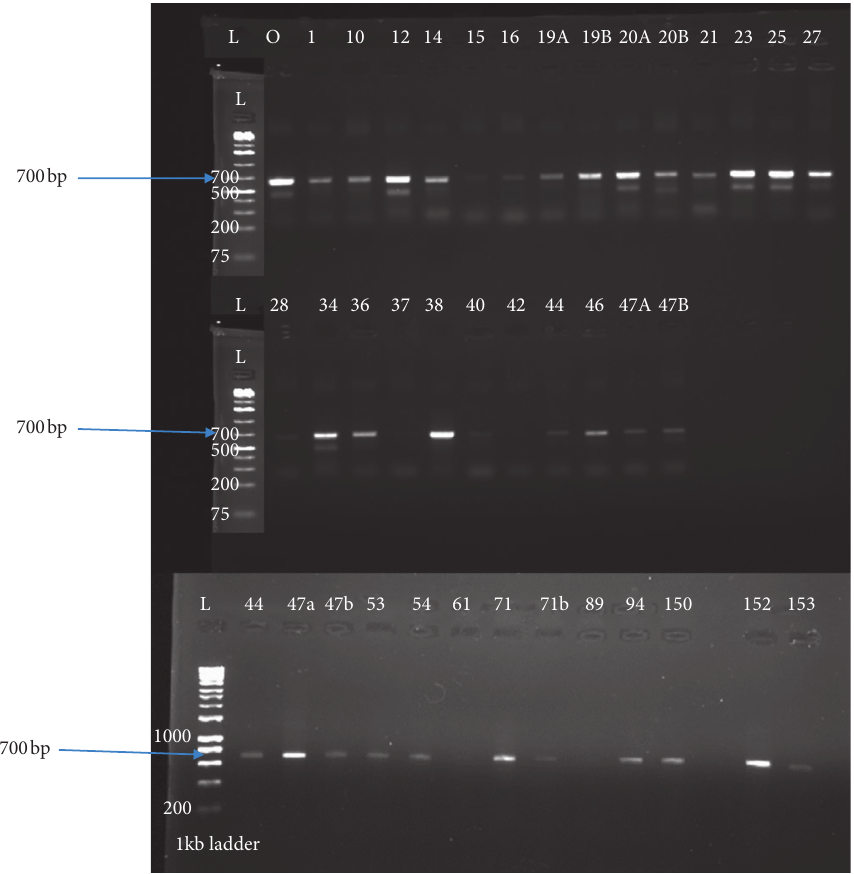
Figure 3: Agarose 1% gel electrophoresis of PCR-amplified elongation factor 1-alpha gene of Fusarium spp. isolated from different genotypes of wheat seeds in three Rift Valley regions, Kenya. Amplification band of 700-710bp shows positive results for identity of Fusarium